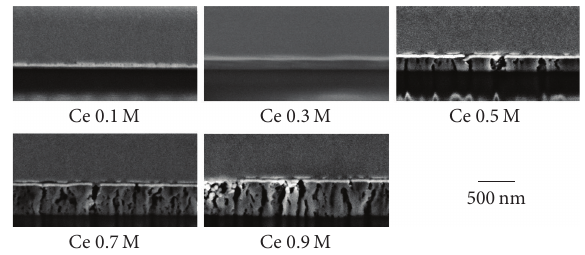
F 3: FIB images of the cross-sectional areas of the CeO produced using solutions of varying Ce concentrations.